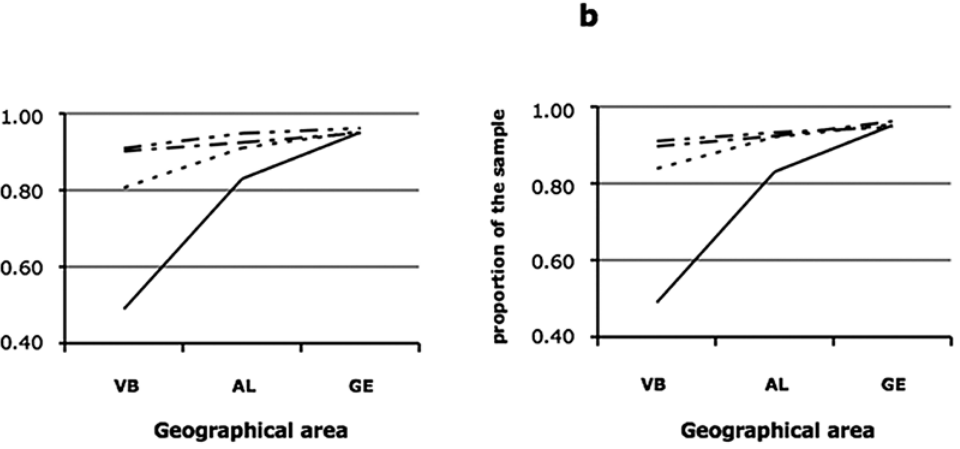
Figure 4. Birthplace distribution of the participants (continuous line), their parents (dotted line) and their grand parents (grandfather: one dot/line; grandmother: two dots/line) in progressively larger geographical areas: Val Borbera (VB) and the two surrounding provinces of Alessandria (AL) and Genova (GE). a: maternal lineage; b: paternal lineage.